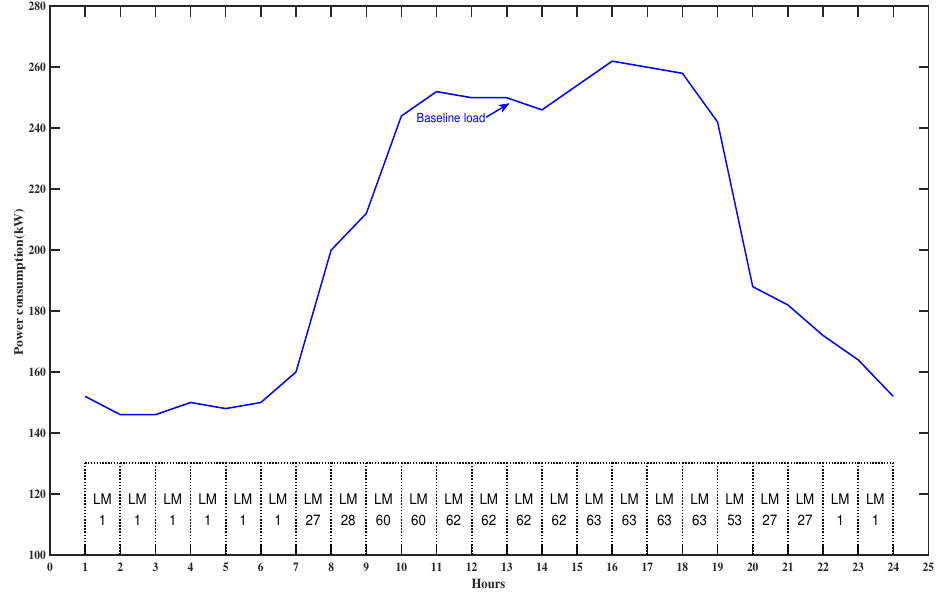
Figure 8. Linear model is selected for each time slot by the MBCRF